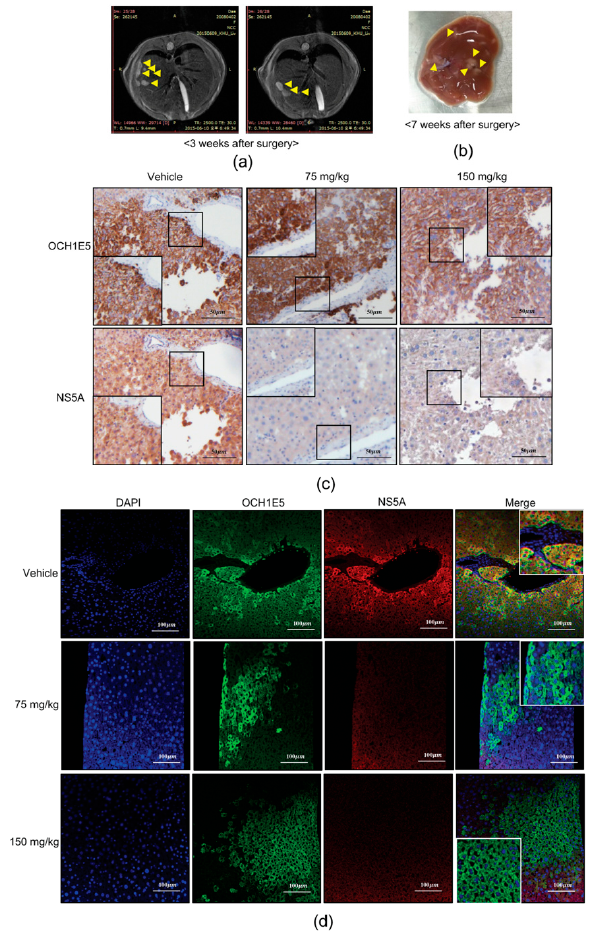
Figure 9. Antiviral effects of 4-PBA in an HCV mouse model. ( a ) MRI results showing the presence of cells injected into the spleen. MRI scans were performed on mice 3 weeks after intrasplenic injection. Animals were positioned on a probe in a head-first, prone position. T2-weighted images at 4.7 Tesla were obtained for 16 coronal sections at a slice thickness of 0.7 mm. ( b ) Morphology of mouse liver at 7 weeks. Yellow arrowheads indicate the formation of tumor-like clusters by injected Huh7.5-Con1 cells. ( c , d ) Immunohistochemical ( c ) and immunofluorescence analyses ( d ) of OCHIE5 and NS5A expression in liver tissues of the HCV mouse model 7 days after treatment with 4-PBA. Scale bar = ( c ) 20 µ m, ( d ) 100 µ